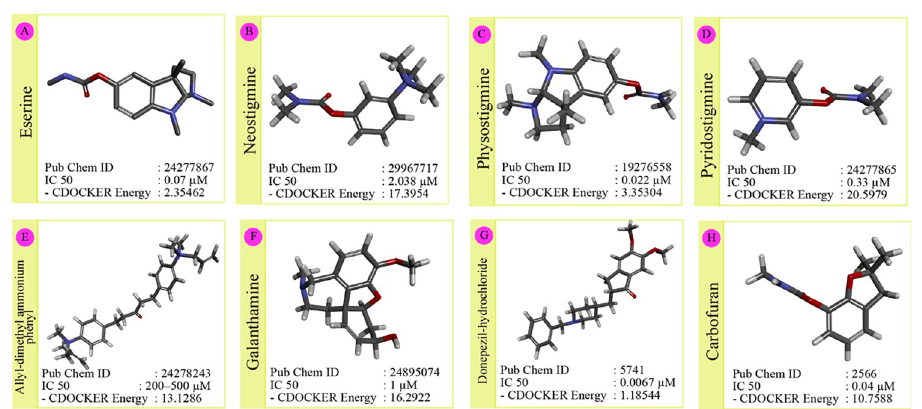
Fig 1. Selection and screening of AChEI drugs. AChEI drugs were screened based on negative CDocker energy and IC 50